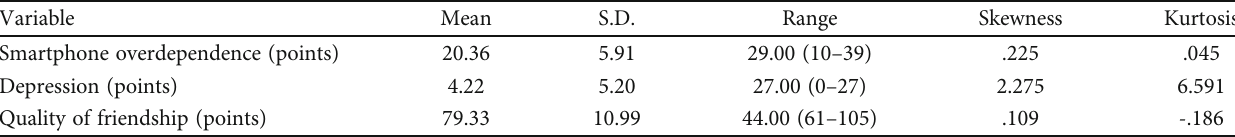
Table 2: Results of the analysis of each variable.